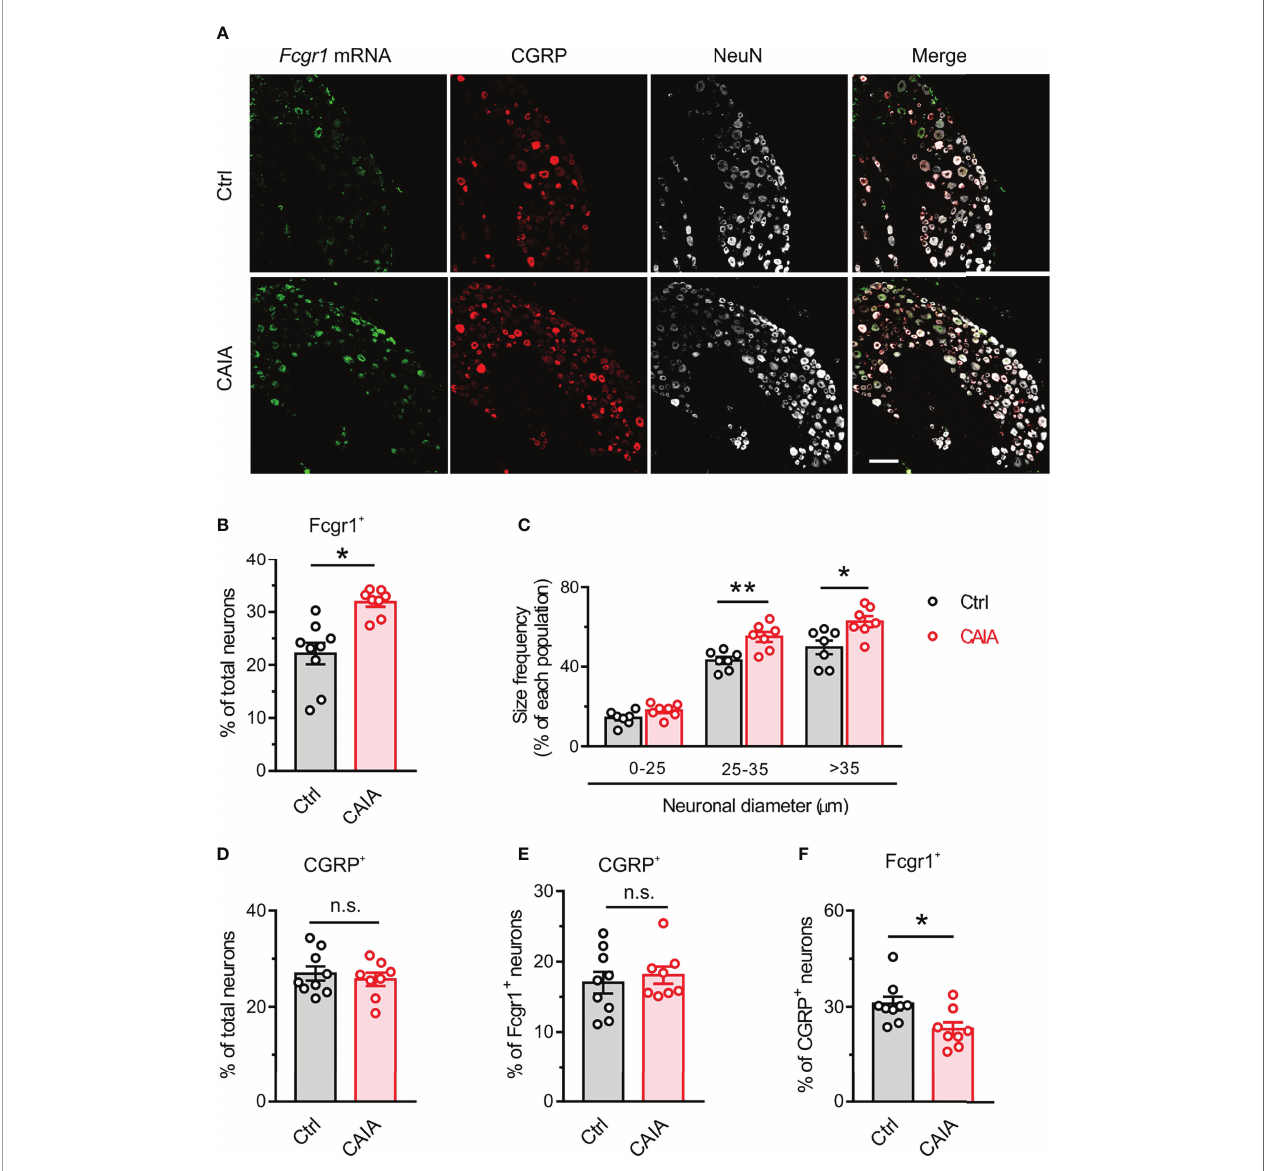
FIGURE 6 | Fc g RI mRNA expression is upregulated in DRG neurons in the postinlfammatory phase of CAIA. (A) Representative lumbar DRG ISH for Fcgr1 and immunostaining for CGRP and NeuN from control and CAIA mice on day 56 after challenge. Scale bar, 50 m m. (B) Percentage of Fcgr1 + neurons among all DRG neurons in control (Ctrl) and CAIA mice. n = 7-8 mice per group; *p < 0.05 versus control; unpaired Student ’ s t test. (C) Size frequency distribution of Fcgr1 mRNA expression in each cell size population in DRG neurons of control and CAIA mice on day 56 after immunization. n = 7 mice per group; *p < 0.05, **p < 0.01 versus Ctrl; unpaired Student ’ s t test. (D) Percentage of CGRP + neurons among all DRG neurons in control and CAIA mice. n = 8-9 mice per group; p > 0.05 versus Ctrl; unpaired Student ’ s t test. (E) Percentage of Fcgr1 + neurons among CGRP + neurons in control and CAIA mice. n = 8-9 mice per group; P > 0.05 versus Ctrl; unpaired Student ’ s t test. (F) Percentage of CGRP + neurons among Fcgr1 + neurons in control and CAIA mice. n = 8-9 mice per group; *p < 0.05 versus Ctrl; unpaired Student ’ s t test. n.s., not signi fi